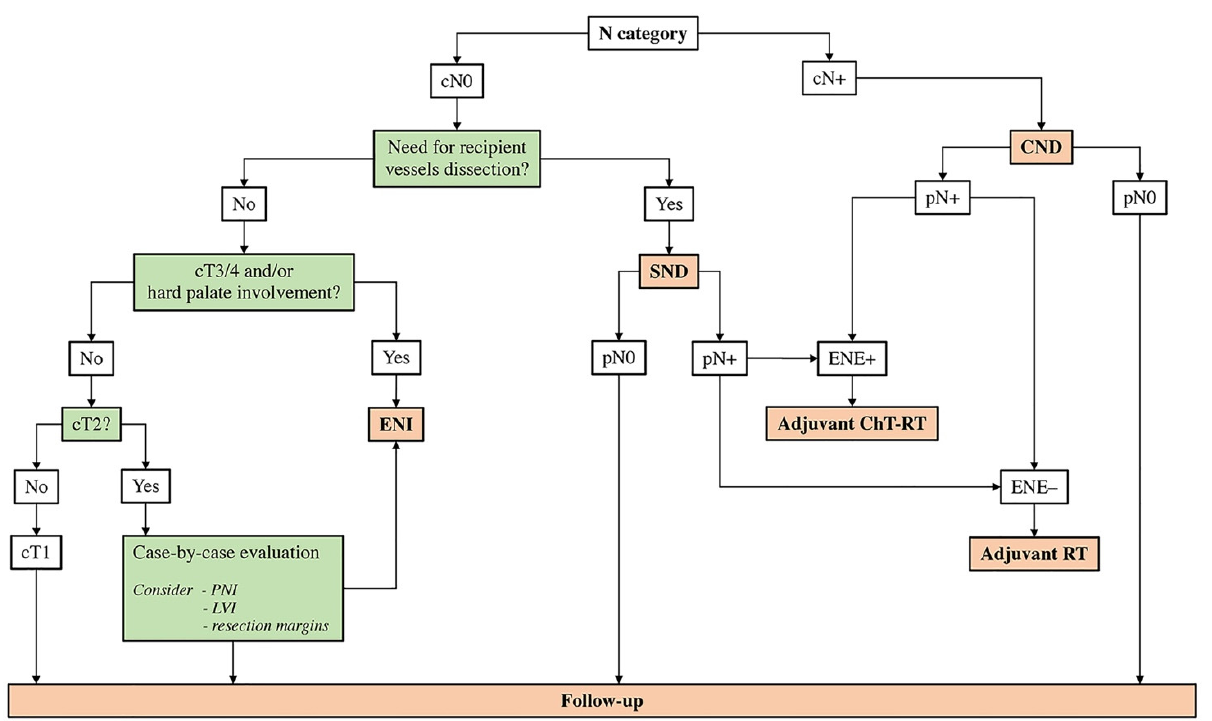
Figure 4. Flowchart summarizing the neck management strategy proposed based on available literature and authors’ experience. CND, comprehensive neck dissection; ChT, chemotherapy; ENE, extranodal extension; ENI, elective neck irradiation; LVI, lymphovascular invasion; N, nodal; PNI, perineural invasion; RT, radiotherapy; SND, selective neck dissection.